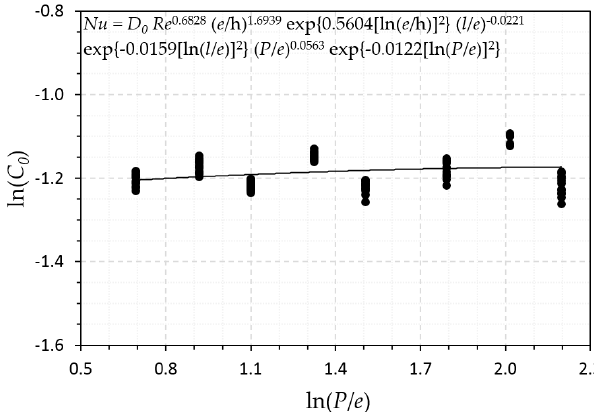
Figure 18. Plot of ln ( 𝐶 (cid:2868) ) as function of ln ( P / e ).